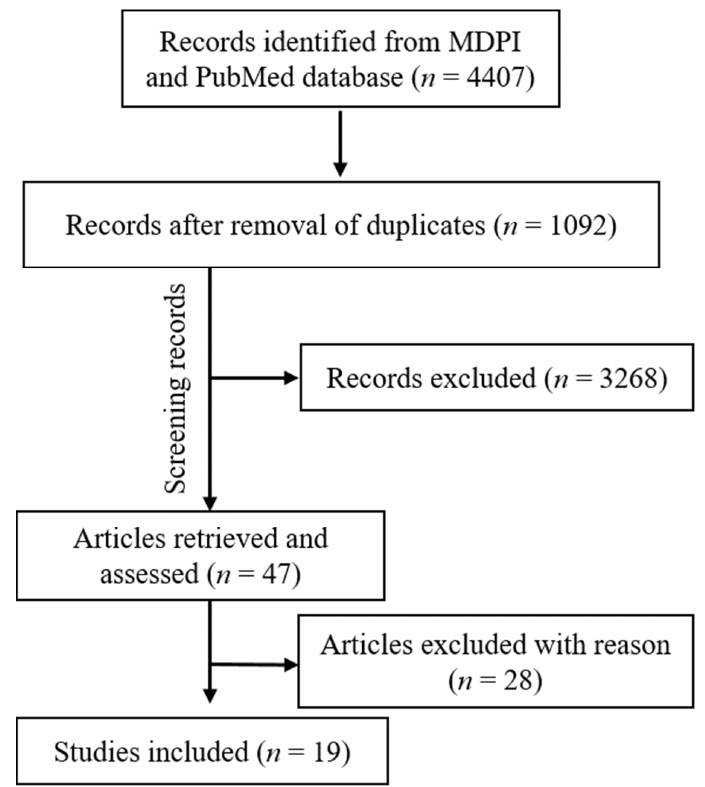
Figure 3. Articles included in the current study (MDPI and PubMed).